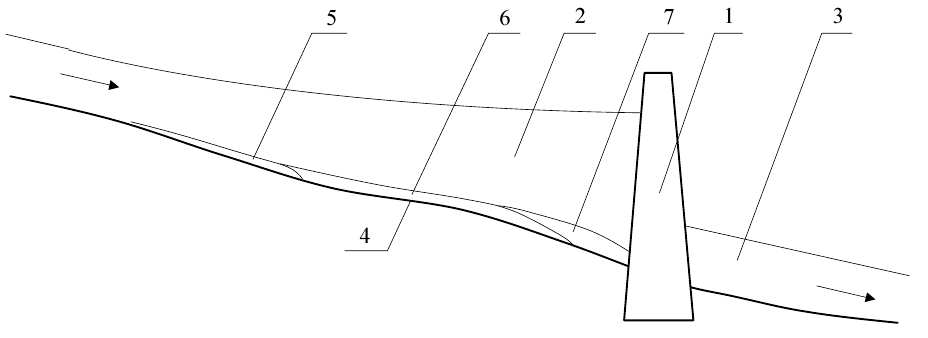
Fig. 7. Scheme of a river longitudinal section: 1 – dam; 2 – pool; 3 – downstream reach; 4 – riverbed profile; 5, 6 and 7 – coarse, mid-size and fine